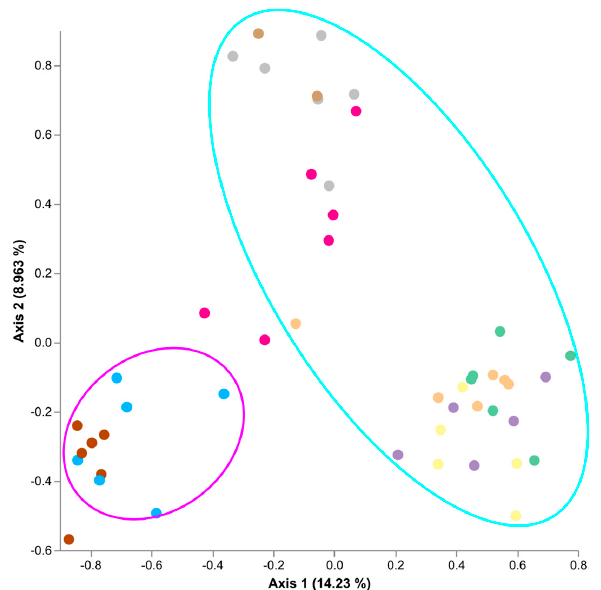
Figure 2. Jaccard similarity plots demonstrating the differences between Single Seeds; Trojan (cyan) and Alto (magenta) rings.